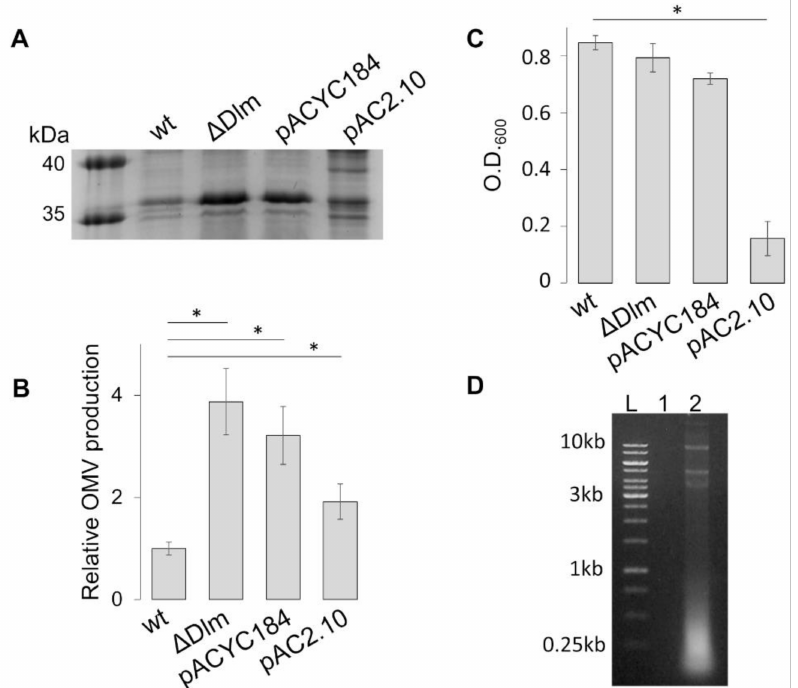
Figure 3. Trans-complementation of the SRRz/Rz1 operon confers a lytic phenotype to ULS153 ∆ Dlm. ( A ) SDS-PAGE separation of OMV proteins from ULS153 (wt), ULS153 ∆ Dlm), UL153 ∆ Dlm carrying the pACY184 vector ( ∆ Dlm pACY184), and UL153 ∆ Dlm carrying pAC2.10, a pACYC184- derived plasmid harboring a functional copy of the SRRz/Rz1 operon ( ∆ Dlm pAC2.10). ( B ) OMV production of ULS153 ∆ Dlm, ULS153 ∆ Dlm pACY184 and ULS153 ∆ Dlm pAC2.10 normalized to the ULS153 wt strain. OMV amount was obtained by densitometry of the OmpF/C band in SDS-PAGE separations. ( C ) Growth measurements (OD 600 ) of ULS153 wt, ULS153 ∆ Dlm, ULS153 ∆ Dlm pAC184 and ULS153 ∆ Dlm pAC2.10 after overnight cultures. Vertical bars indicate the standard deviation of three independent experiments. Statistical significance was determined by the t test, and p values are as follows: * p < 0.01. ( D ) Agarose gel separation of DNA purified from overnight culture supernatants of ULS153 ∆ Dlm pACYC184 (lane 1) and ∆ Dlm pAC2.10 (lane 2). The presence of DNA is detectable only in ULS153 ∆ Dlm pAC2.10. L, mw markers